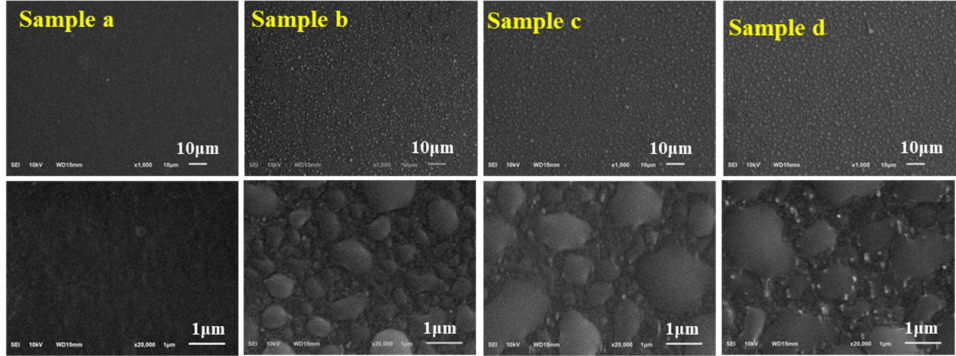
Figure 4. SEM images of pristine BOPP film and corona BOPP film for di ff erent